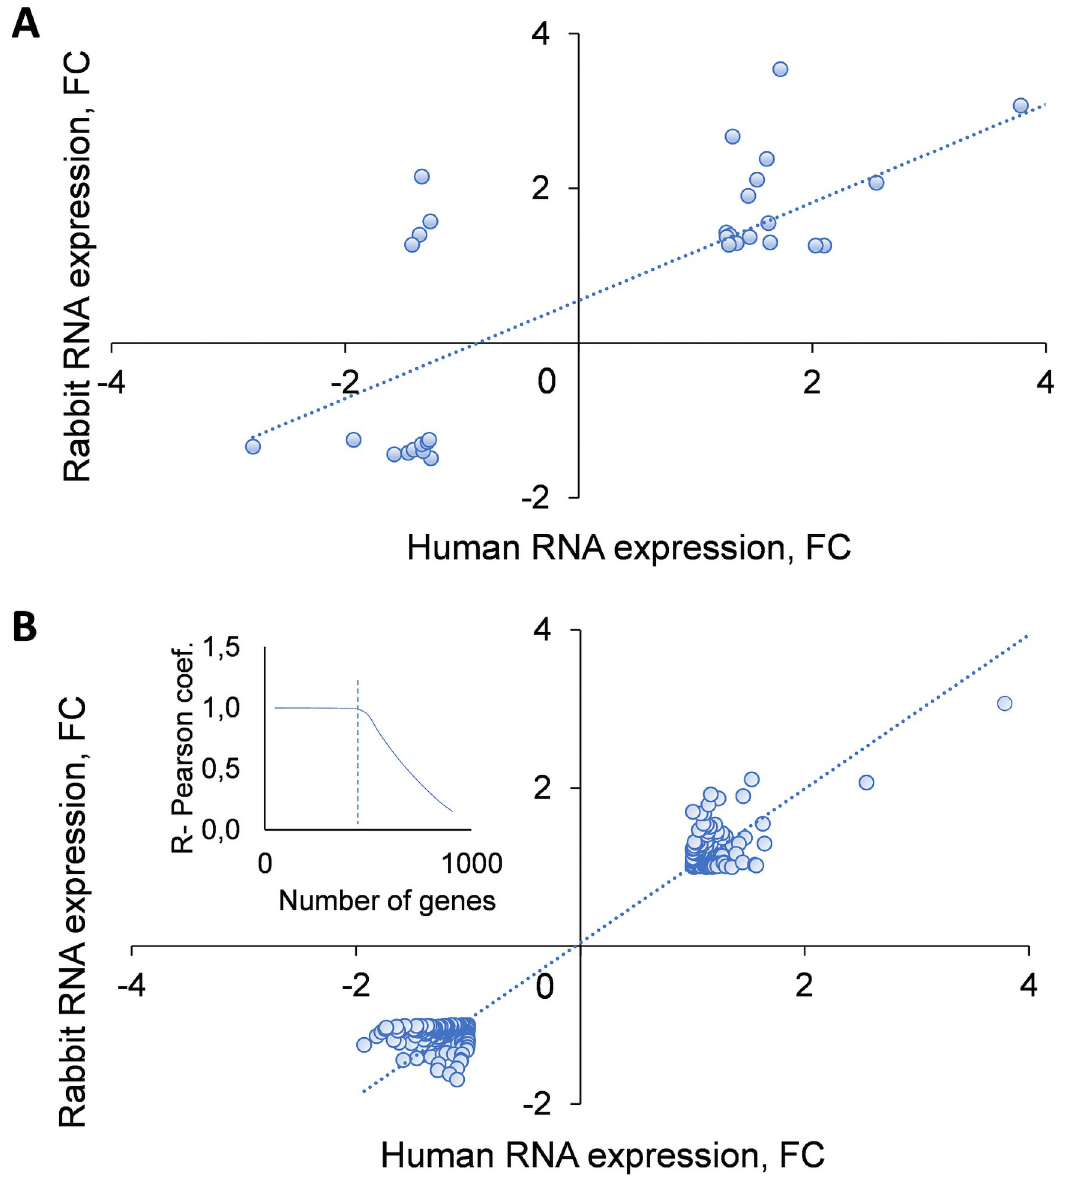
Fig 7. Correlation of gene expression between DED patients without Sjogren syndrome and rabbits with DED. A. Gene expression in rabbits with DED was compared to that in patients with non-Sjogren’s syndrome DED. There was a significant correlation between the 32 most changed rabbit and the corresponding human genes included in this analysis (FC � 1.3 up- or down- regulated, PCC R = 0.545; p-value < 0.001; n = 32). B : The expression of 475 of 910 human genes included in this analysis (that were annotated in rabbit transcriptome arrays), was similar in both species (PCC R = 0.917, p < 0.0001), as described in Methods. The most correlated genes were cut-off by using the inflection point, determined by the function (small graph on the left) of similarly expressed genes (in both species) and calculated PCC Rs (S1